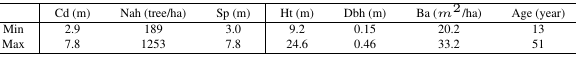
Table 1: Range of variations of forest variables over 12 sampled